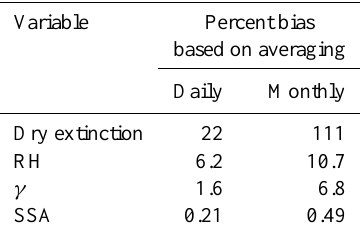
Figure 14. Average SSA for each flight (top) along with estimated ambient extinction and percent bias if the flight-average (left) and campaign-average (right) SSA are used. Table 2. Percent bias in ambient extinction based on daily and monthly averaging of contribution